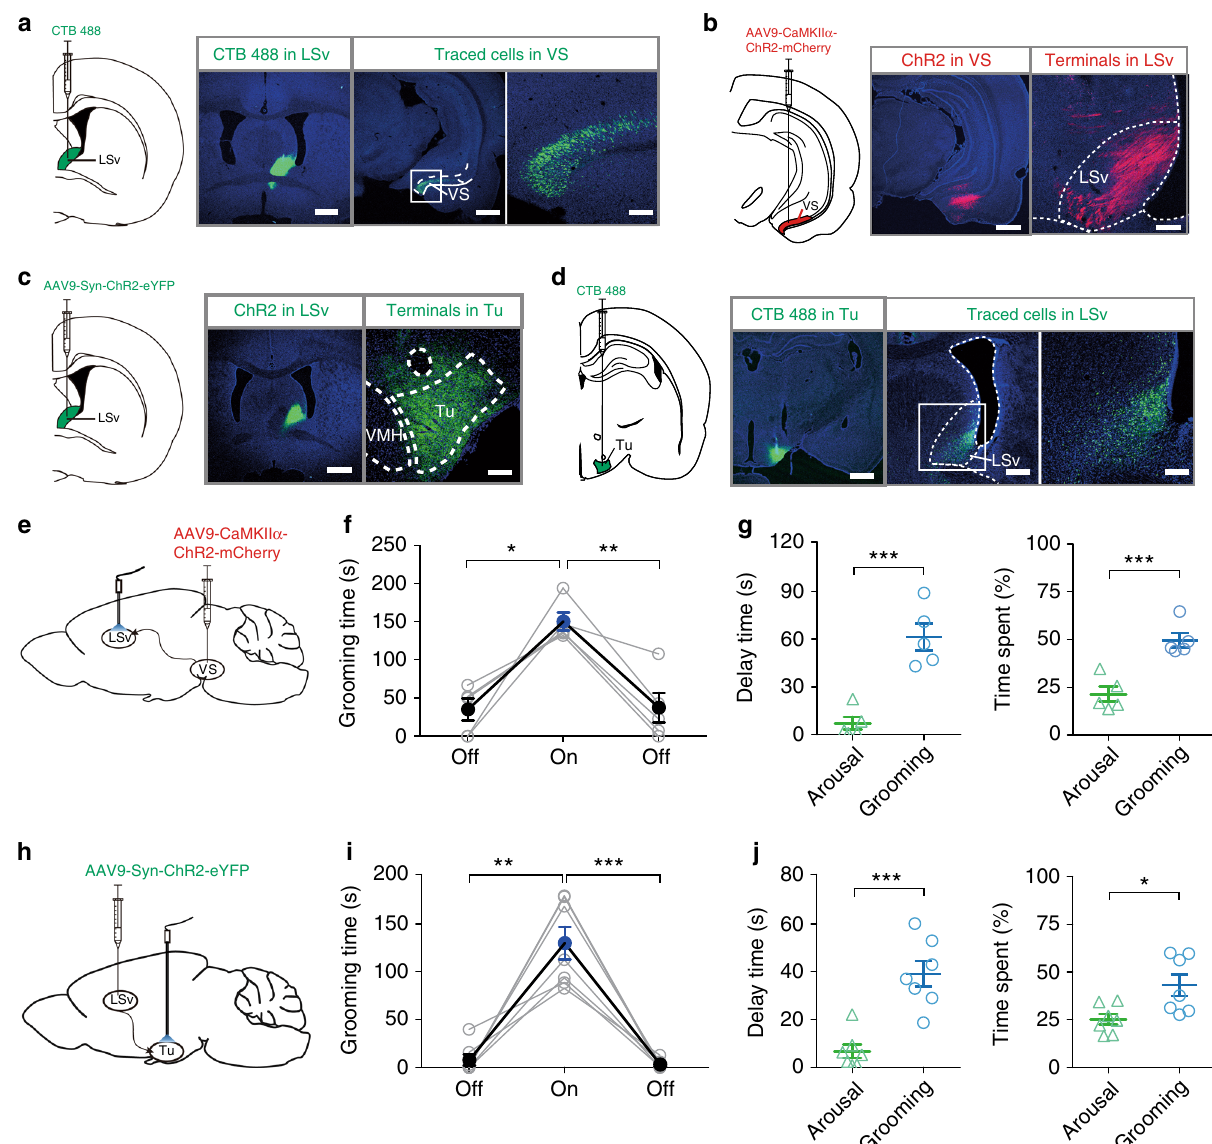
Fig. 2 Mapping upstream and downstream nuclei of LSv contributing to self-grooming. a Retrograde labelling by CTB-488 microinjection in the LSv resulted in prominent expressions in the ventral subiculum (VS) of the hippocampal formation in the ipsilateral brain. Scale bar, 1000 μ m. Inset shows enlarged ventral subiculum. Scale bar, 200 μ m. b Anterograde tracing by injection of AAV9-CamIIK α -ChR2-mCherry con fi rmed the VS-LSv projection. Left, scale bar, 1000 μ m; Right, scale bar, 200 μ m. c Anterograde tracing by AAV9-hSyn-hChR2(H134R)-eYFP microinjection in the LSv resulted in prominent expressions in the tuberal nucleus (Tu) of the lateral hypothalamus. Left, scale bar, 1000 μ m; Right, scale bar, 200 μ m. d Injection of CTB-488 into Tu con fi rmed the LSv-Tu projection. Left, scale bar, 1000 μ m; middle, scale bar 500 μ m; Right, scale bar 200 μ m. e and f Optogenetic activation of the VS → LSv pathway for 5 min at 25 Hz induced increased grooming behaviour that was signi fi cantly higher than those in the 5-min pre-light and post- light-off periods ( n = 5, One-way repeated measures ANOVA with Tukey post-hoc test, F (1.489, 5.954) = 13.05, P = 0.0083; off vs. on, * P = 0.0189; on vs. post-off, ** P = 0.0096). g Comparison of the delay and time spent in grooming and arousal behaviours, including rearing and heading, in the initial 2 min of stimulation. n = 5; delay time, *** P = 0.0004; time spent, *** P = 0.0009; Student ’ s paired two-tailed t -test. h and i Optogenetic activation of the LSv → Tu pathway for 5 min induced increased grooming behaviour that was signi fi cantly higher than those in the 5-min pre-light-off and post-light-off periods. ( n = 7, one-way repeated measures ANOVA with Tukey post-hoc test, F (1.104, 6.622) = 39.73, P = 0.0004; pre-off vs. on, ** P = 0.0025; on vs. post-off, *** P = 0.0010). j Comparison of the delay and time spent in grooming and arousal behaviours, including rearing and heading, in the initial 2 min of stimulation. ( n = 7; delay time, *** P = 0.0002; time spent, ** P = 0.0147; Student ’ s paired two-tailed t -test). All data are are presented as mean ± SEM. Source data are provided as a Source Data fi LSv → Tu projections in triggering self-grooming behaviour, we upper panel) and prepared brain slices for whole-cell recordings asked whether the neurons in LSv that receive command from the targeting LSv neurons that were tagged with biocytin during VS are the same neurons conveying grooming-related signals to recording. It was found that many neurons that generated EPSCs the downstream Tu. To address this question, we fi rst injected in response to photo-stimulation of VS terminals also expressed AAV9-Syn-ChR2-eYFP into VS and CTB-555 into Tu (Fig. 4a, CTB signal (Fig. 4a, lower panel), con fi rming the presence of a